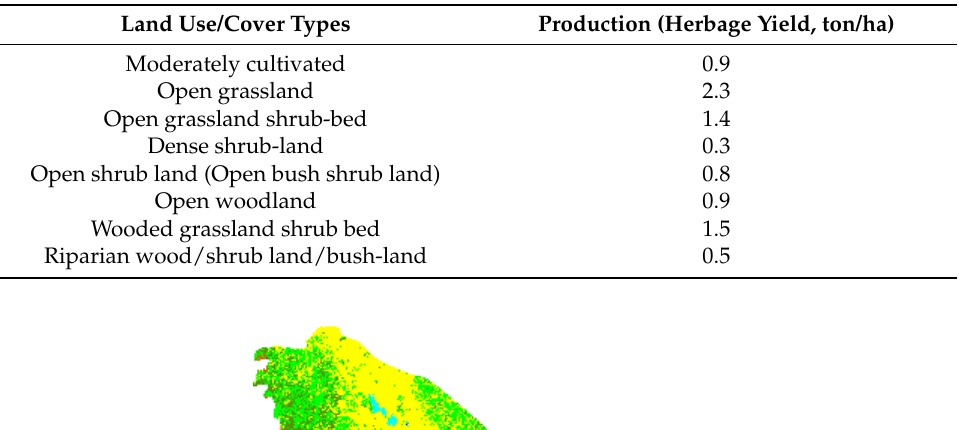
Table 2. Biomass production by land use [60].